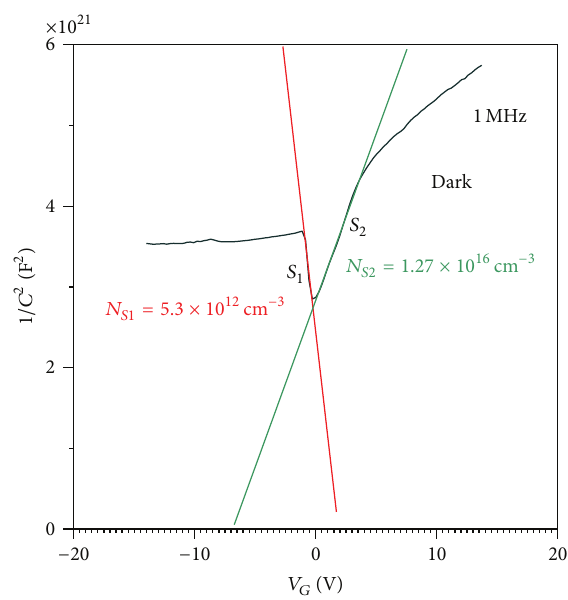
Figure 4: Dark 1/ C 2 -V